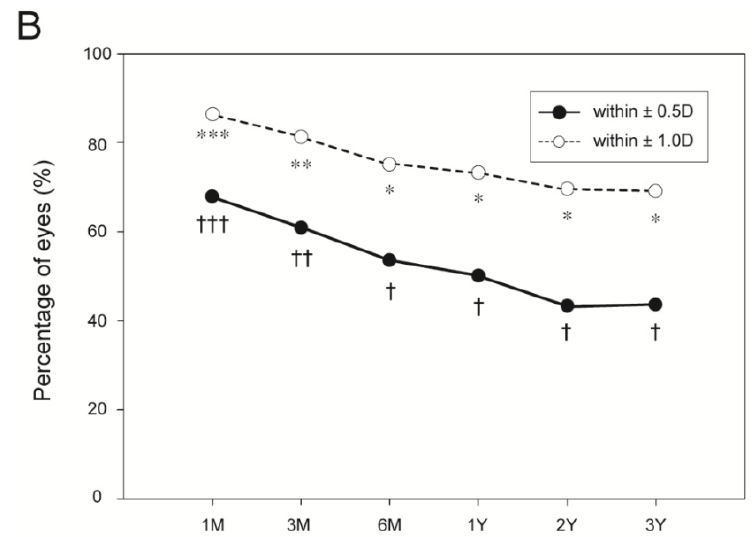
Figure 2. Distribution of postoperative spherical equivalents at 3 months and 3 years postoperatively ( A ) and percentage of eyes within ± 0.50 and ± 1.00 D emmetropia (in terms of spherical equivalent) at the indicated postoperative periods ( B ). ***, ** and *; †††, †† and † indicate significant differences between these time points (all p < 0.005). SE = spherical equivalent.